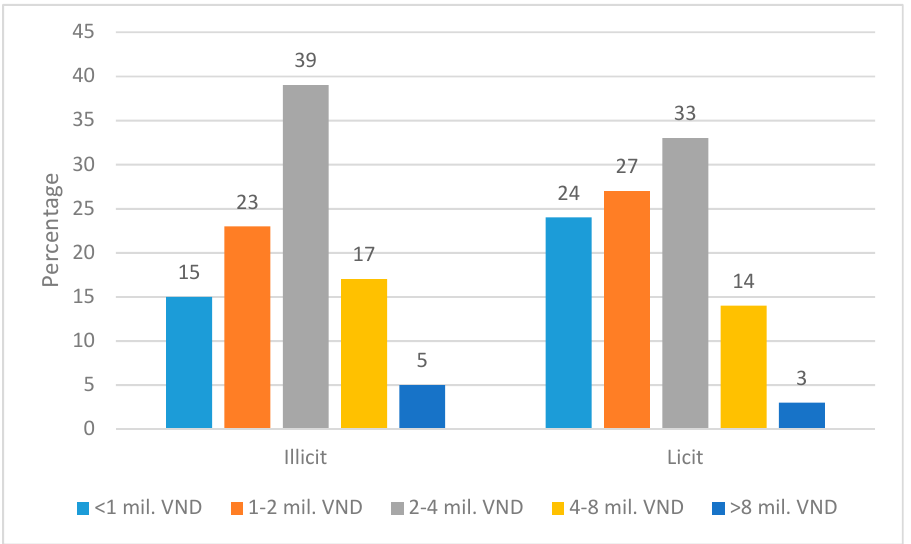
Figure 1. Monthly Income Distribution of Illicit/Licit Cigarette Smokers.